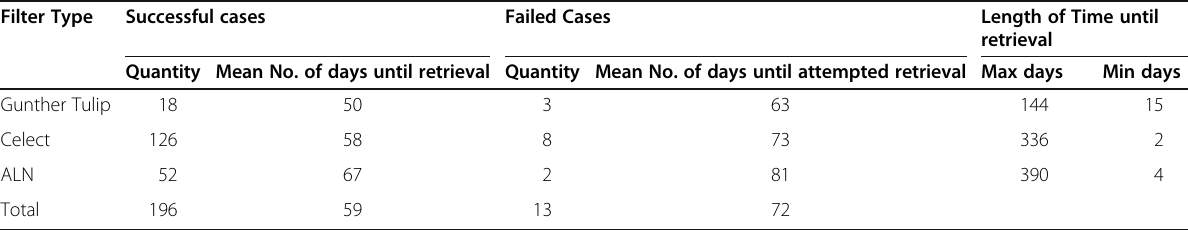
Table 4 Mean dwell time by Filter Type ( n = 209) Filter Type Successful cases Failed Cases